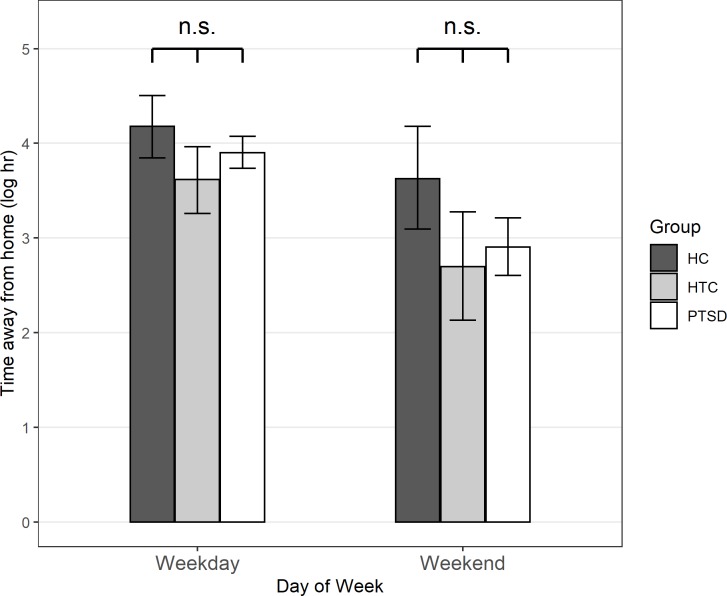
Mean (logarithmized) time away from home on weekdays and weekend days for all groups.Mean (logarithmized) time away from home on weekdays (left) and weekend days (right), separately for the healthy control group (HC; dark grey), the healthy trauma control group (HTC; light grey), and the patient group (PTSD; white). Statistical significance in the figure refers to the results from the main analyses (no covariates): *p < .05, n.s.: p > .05.